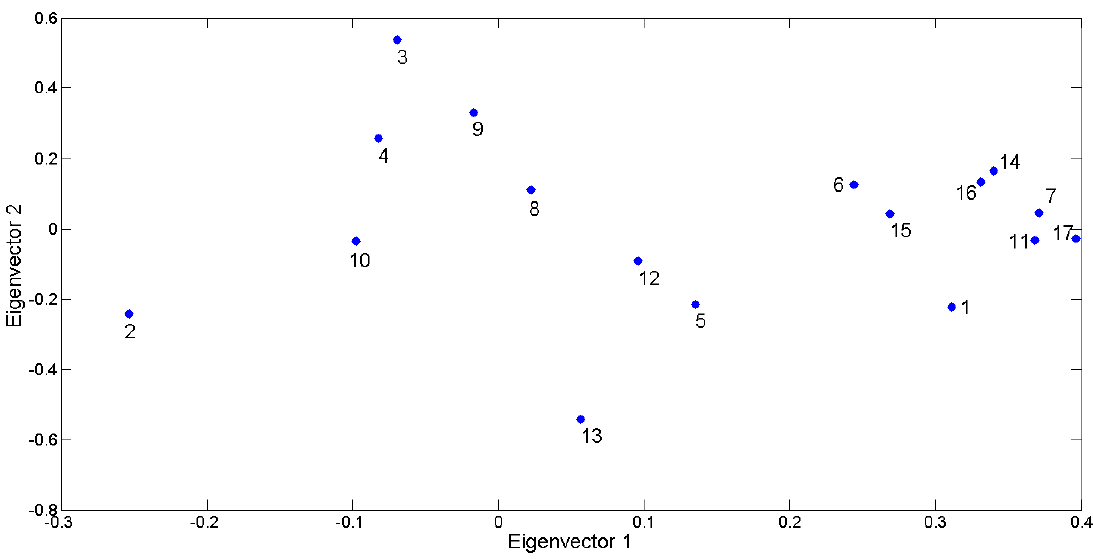
Figure 10. 2D visual representation of the data variability in the computed scores for the 17 ASD children.